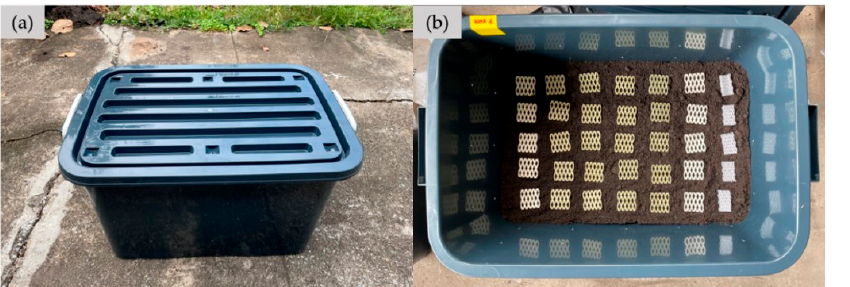
Figure 3. Biodegradation experiment of cushion foams: ( a ) plastic box used for soil burial; ( b ) cushion foam placement.